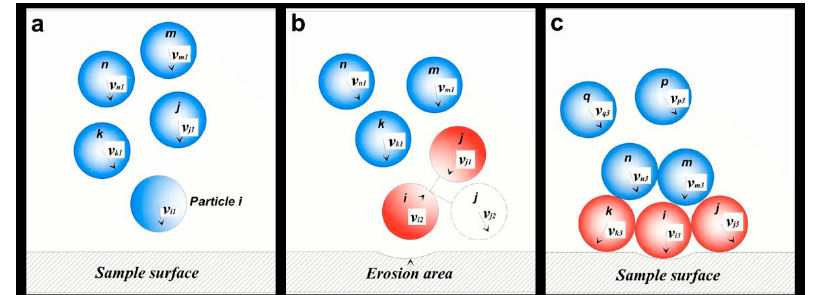
Figure 9. Schematic diagrams of the particle-wall impact and particle-particle collision in a cluster, ( a ) distribution of the particles in pipe flow; ( b ) initial contact between the front particle and the wall; ( c ) the rebound of the front particle; ( d ) mutual interference of the particles.